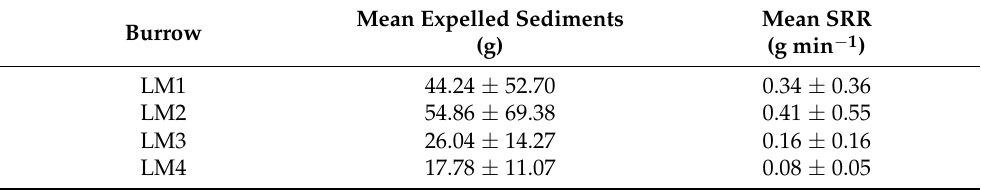
Table 2. Comparison of daily expelled sediments and daily SRR among burrows.